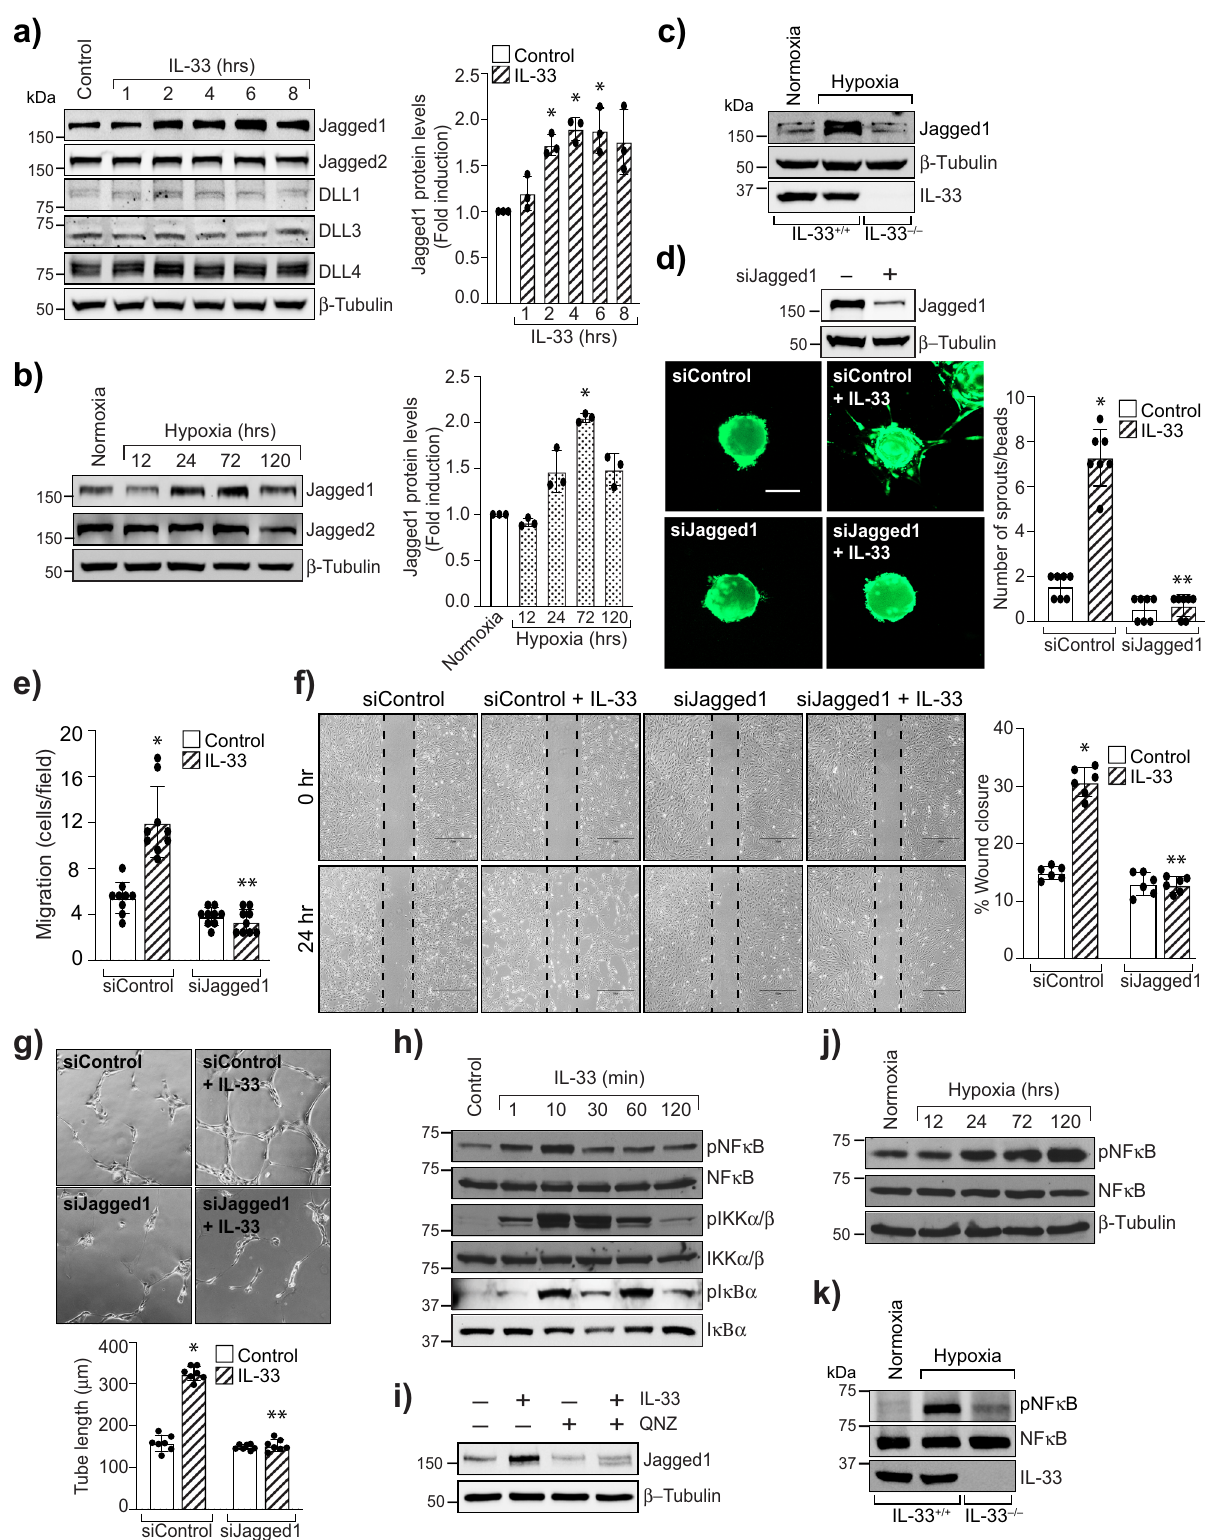
the role for Notch1 signaling in cancer progression and